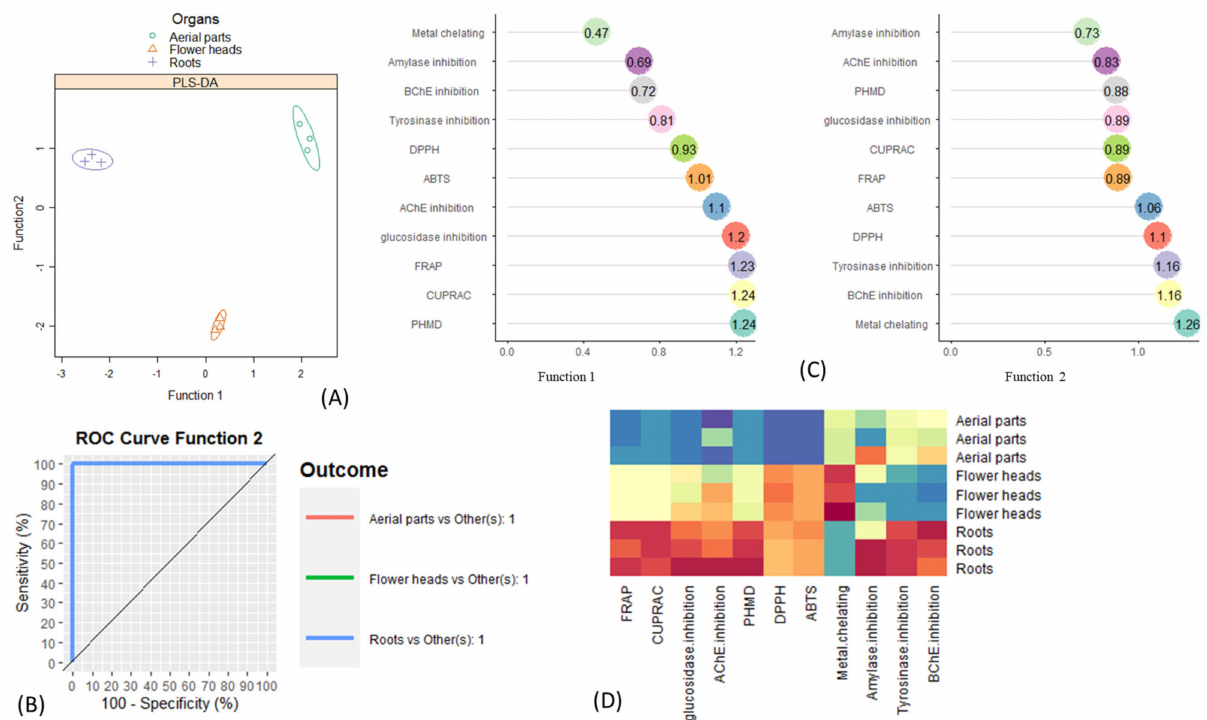
Figure 4. Partial least-square discriminant analysis graphical outputs on the biological activities (with three replications). ( A ) The sample plots. ( B ) Roc curve and AUC averaged using one-vs-all comparisons. ( C ) The most discriminant biological activities identified though VIP score calculation. ( D ) Heatmap displaying variation of biological activities between the three organs. Red color = high activity. Blue color = low